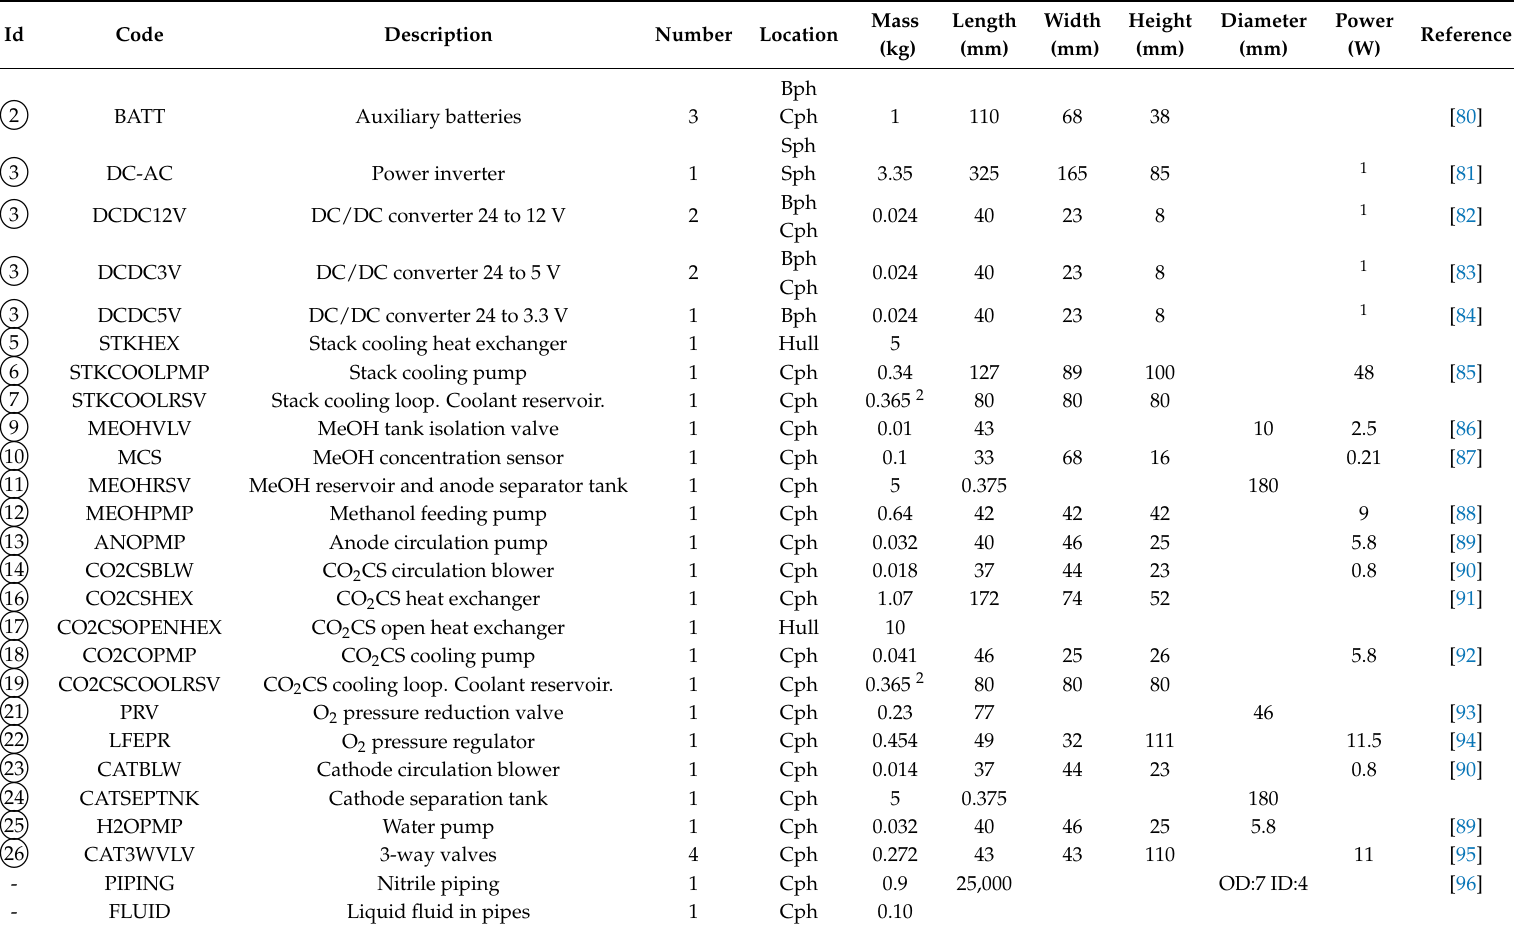
Table A3. BoP components characteristics for Model 1000. Bph, bow pressure hull. Cph, central pressure